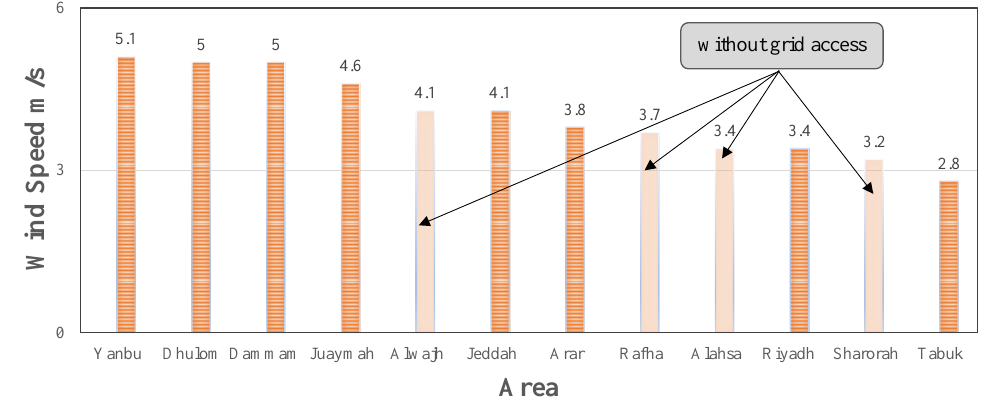
Figure 1. Regional sites of wind turbines in Saudi Arabia.